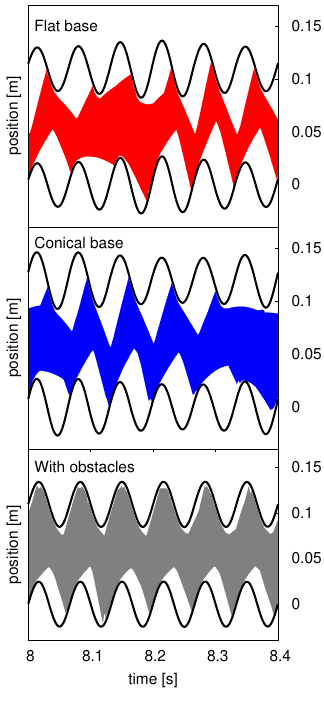
Figure 2. Trajectory of the enclosure and the granular bed for U = 0 . 75 r and 15 Hz for the three GDs considered (see labels). The upper and lower solid line indicate the position of the fl oor and ceiling of the enclosure. The shaded area corresponds to the vertical spread of the grains inside represented by the highest and lowest particle at each time.